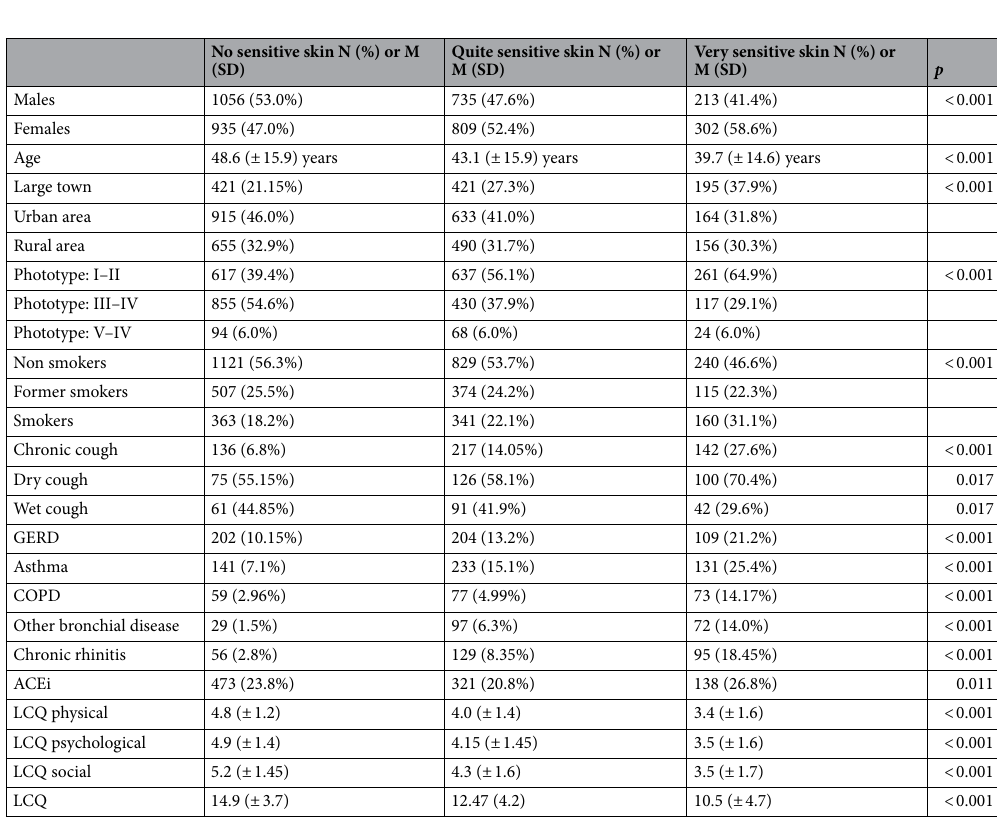
Table 2. Comparisons according to the severity of sensitive